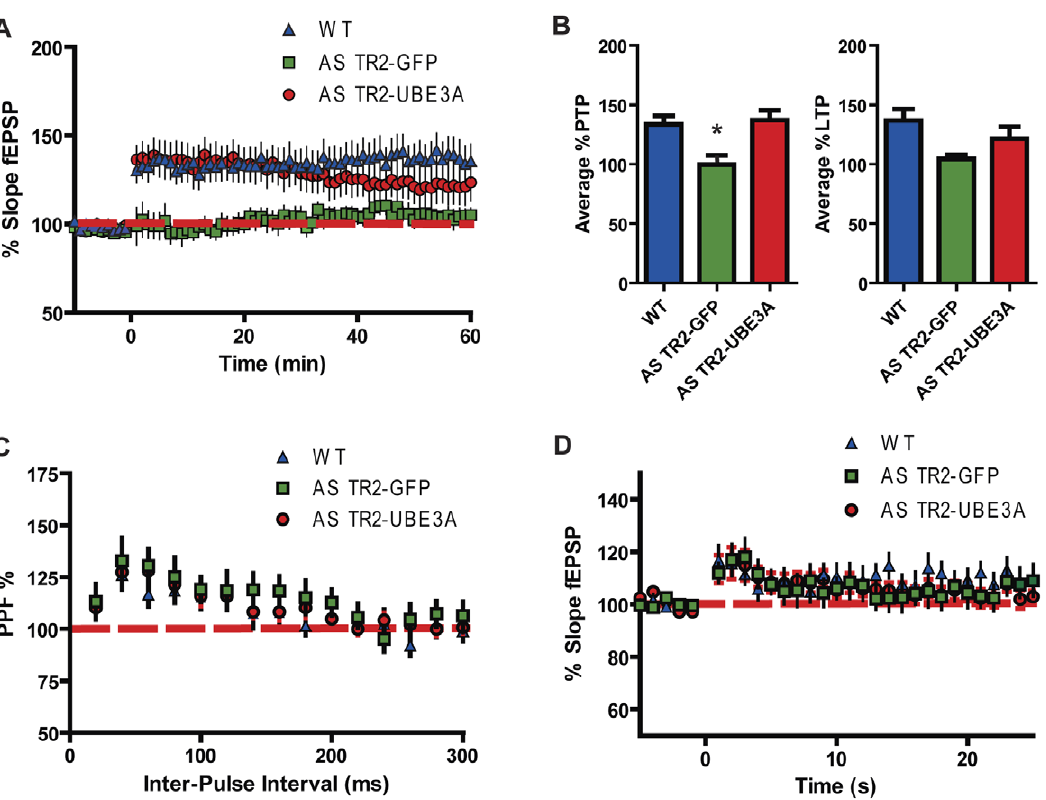
Figure 2. Increasing E6-AP in the AS mouse results in improvements in early phase LTP. (A) AS TR2-GFP mice have significant deficits in hippocampal synaptic plasticity. LTP was induced following 20 min of baseline recordings. (B) Immediately following TBS, acute hippocampal slices taken from AS TR2-GFP mice had significant deficits in the average PTP (average of first 5 min recordings of fEPSPs slopes). To compare late phase LTP, the last 5 min recordings of fEPSPs slopes were averaged, and there was no significant difference between any of the groups. (C) There were no significant differences between any of the groups in either PPF or (D) PTP, indicating that short term synaptic plasticity mechanisms are unaffected. Results shown represent the mean with standard error.